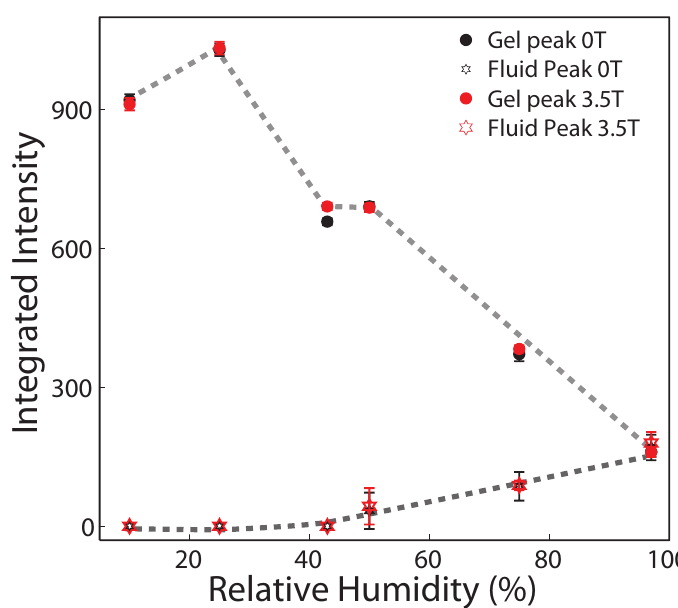
Figure 5. Integrated peak intensities of the gel and fluid correlation peaks from Figure 4 as a function of relative humidity. While gel and fluid peaks have equal intensity at 97% relative humidity, the fluid component reduces with decreased relative humidity and the gel component increases. Intensities for both peaks measured with and without an external magnetic field agree within the resolution of this experiment except at 43% relative humidity. An increase in the gel component with applied field was observed at this relative humidity.